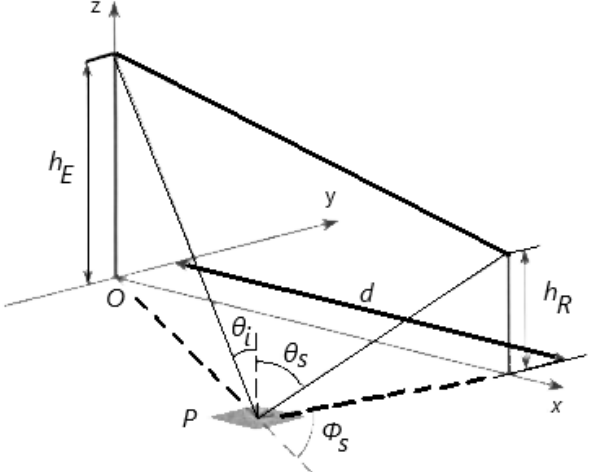
Figure 6. Signal reflection coordinates system, as presented by C.Salema in [27].